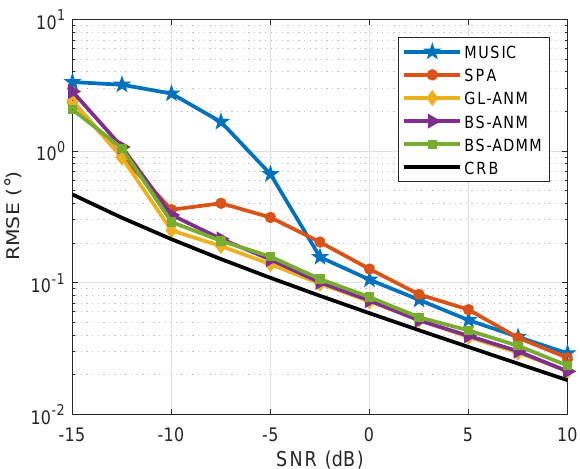
Figure 7. RMSE comparison for correlated sources at θ = 5 ◦ and θ = − 10 ◦ , J = 200 when SNR varies from − 15 to 10 dB, ζ = 0.5.